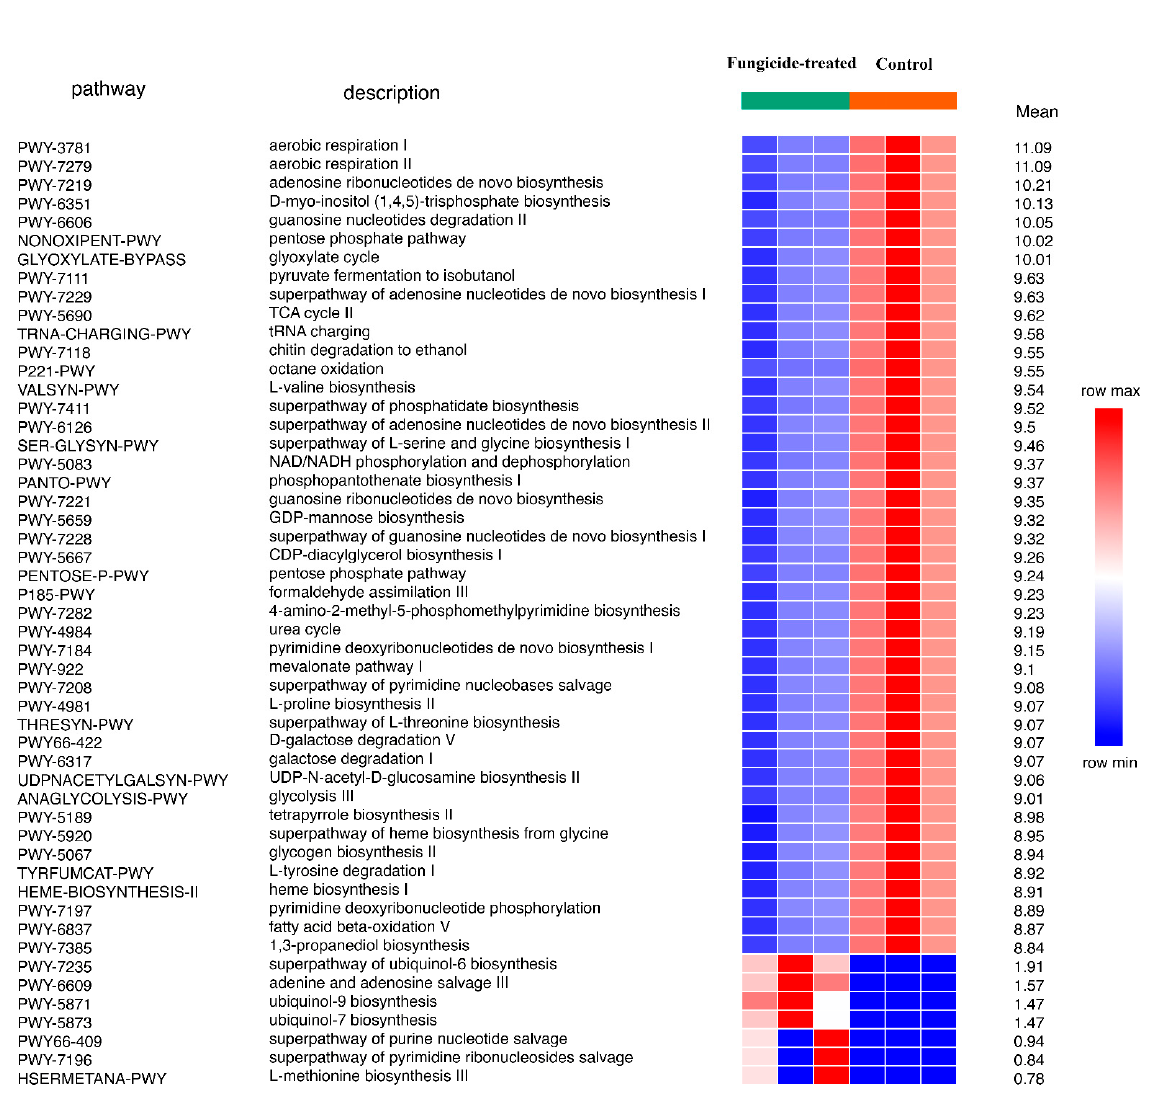
Figure 8. Differentially represented pathways of fungal community between the control and the fungicide-treated soils. The three columns represent three replicate sequencing reactions, and each reaction was based on pooled DNA samples from three biological replicates ( p < 0.05).